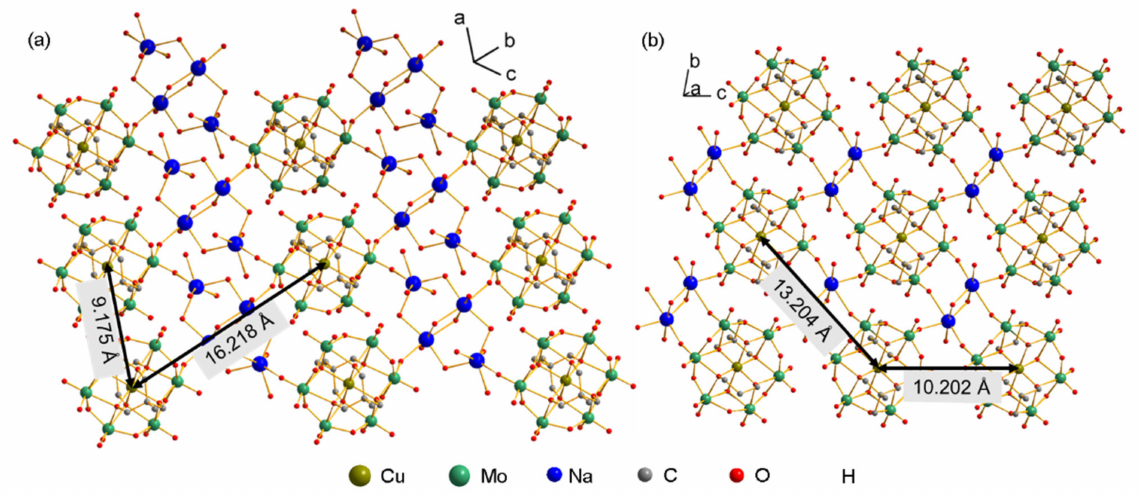
Figure 3. Ball-and-stick representations of compounds ( a ) 8 and ( b ) 9 , showing their 2D planar structures. Numbers in the diagram represent the distances of adjacent clusters in two